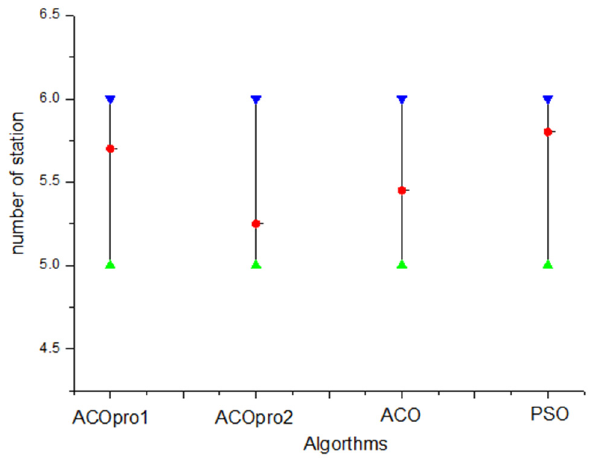
Figure 10. Minimum, average, and maximum values of station number obtained by the comparison algorithms.